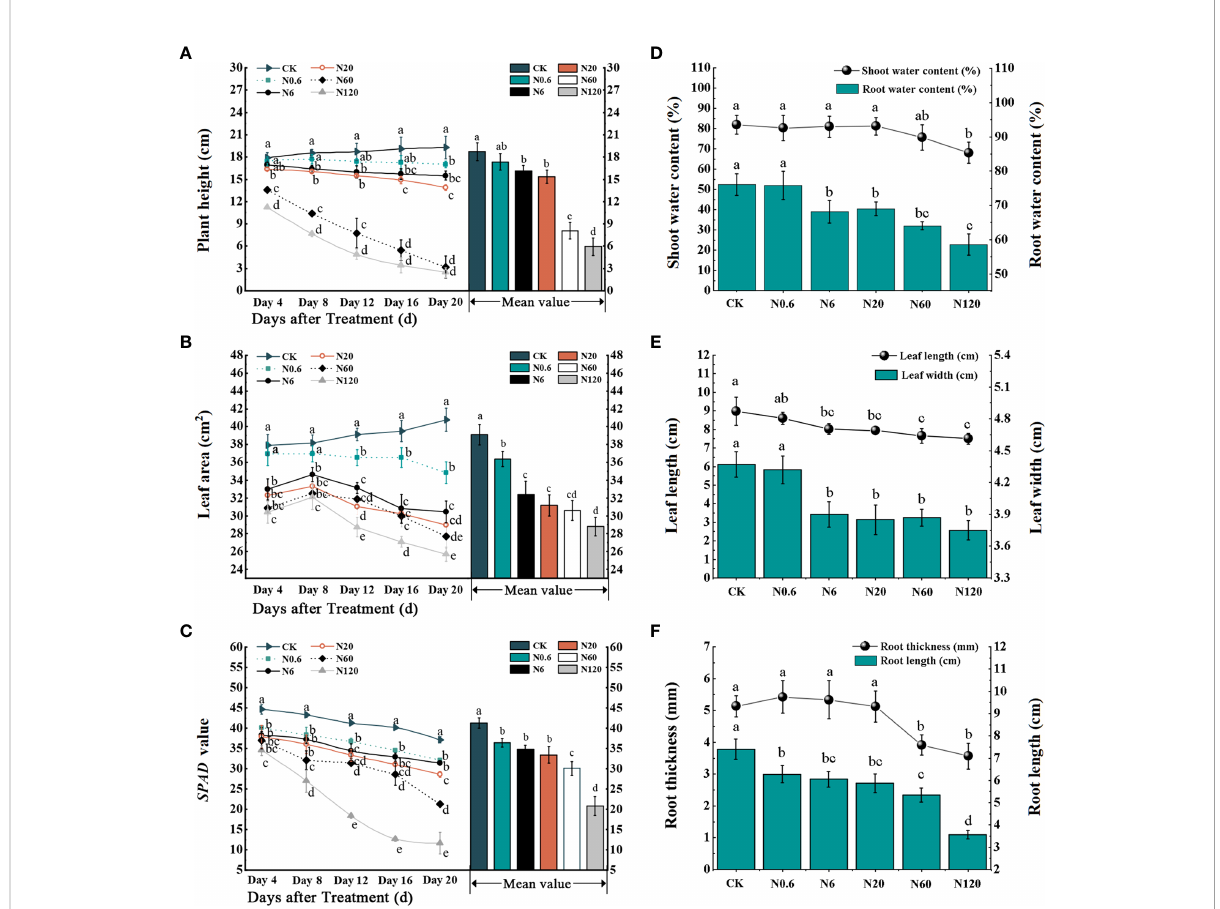
FIGURE 2 Effects of nicosulfuron on the growth parameters of sugar beet. Plant height (A) , leaf area (B) , SPAD value (C) , shoot water content, root water content (D) , leaf width, leaf length (E) , root width and root length (F) in sugar beet with different doses of nicosulfuron. Data with the different letters indicate signi fi cant differences between different doses of nicosulfuron drift (n = 6, p <